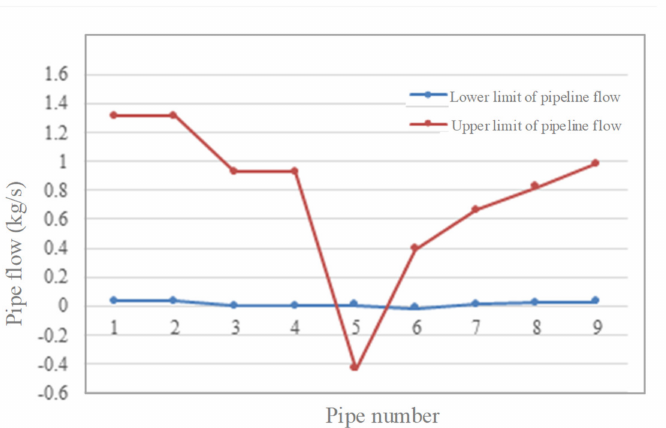
Figure 4. Pipeline flow in thermal system with uncertainty under low load.